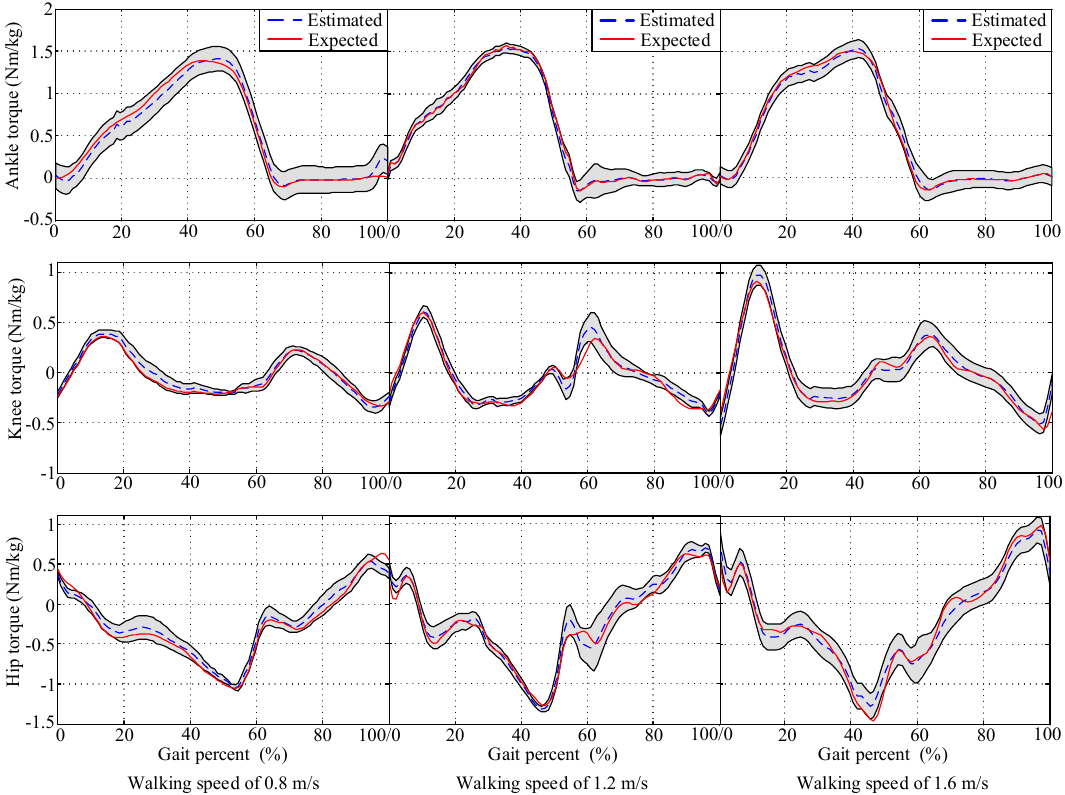
Figure 5. Estimation results of joint torques at walking speed of 0.8, 1.2, and 1.6 m/s, respectively; 95% confidence intervals shown in gray.